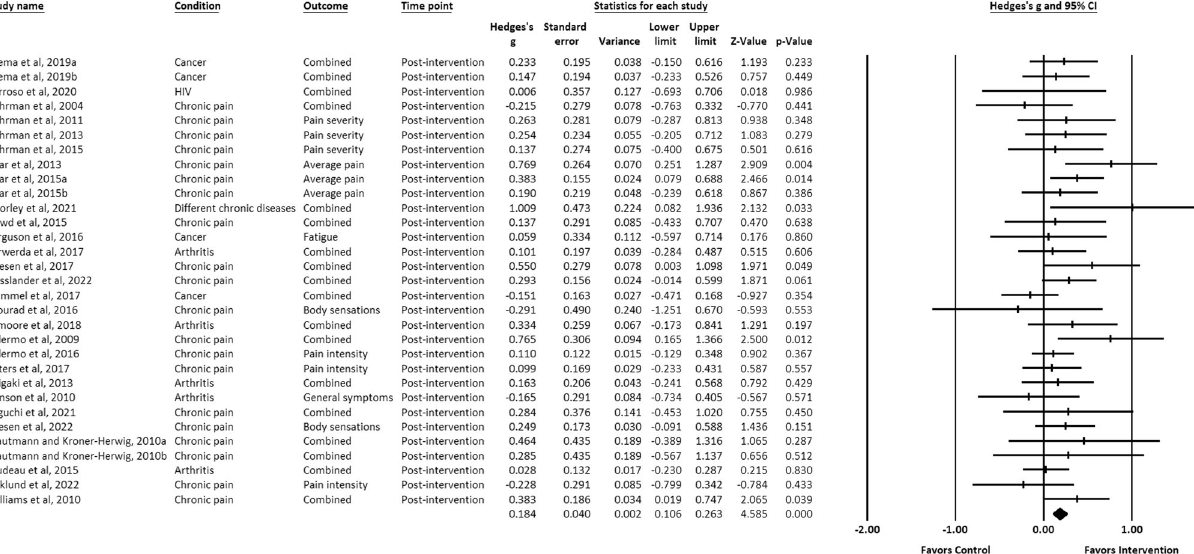
Fig. 11 Forest plot for effect sizes of IM-CBT on physical symptoms at post-intervention. Note. “ Combined ” (under the column “ Outcome ” ) indicates that multiple outcomes on physical symptoms were retrieved and averaged from the same